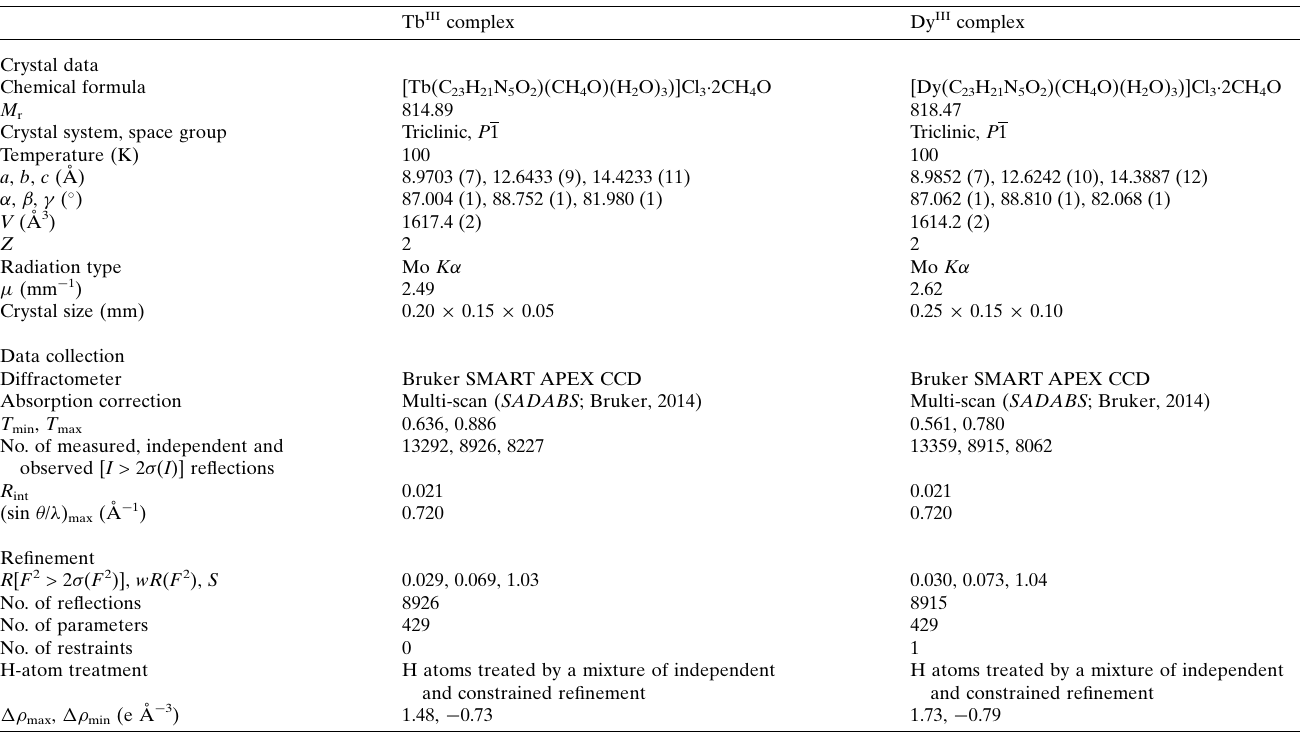
Table 4 Experimental details.